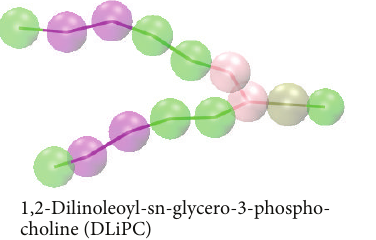
Figure 2: Coarse-grained structures of phospholipids in the simulation. Bead of atoms are presented by colored beads. Ethanolamine head group are blue bead, brown for phosphate, glycerol backbone pink, green for hydrocarbon tail groups, and purple for the double